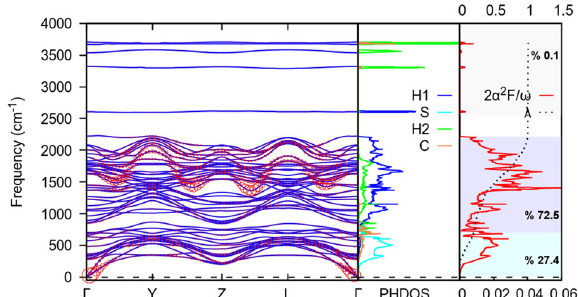
Fig. 5 Superconducting properties of Cm CS 3 H 13 . Phonon band structure, phonon density of states (PHDOS), Eliashberg spectral function in the form of 2 α 2 F ð ω Þ ω , and the electron phonon integral, λ ( ω ), for Cm CS 3 H 13 at 270 GPa. Red circles indicate the electron- phonon coupling constant, λ q ν , at mode ν and wavevector q , and (cid:1) (cid:3) their radii are proportional to the strength. H1 are the hydrogen H 2 ! atoms in the S-H lattice, and H2 are the hydrogen atoms in CH 4 . The (cid:4) (cid:5) 2 R ω 2 λ ð ω Þ d ω = λ ´ 100 % ; and percentages given were calculated via ω 1 the frequency regions spanning ω 1 and ω 2 are color coded in the